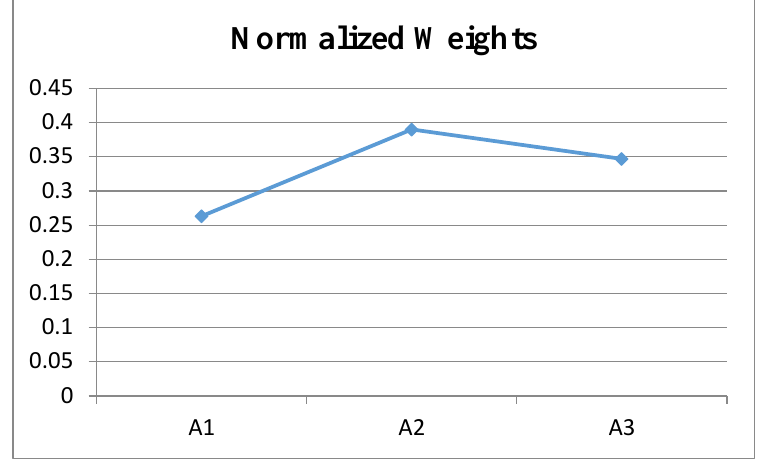
Fig. 4. Final VLAM results for the case study by ε=ε *